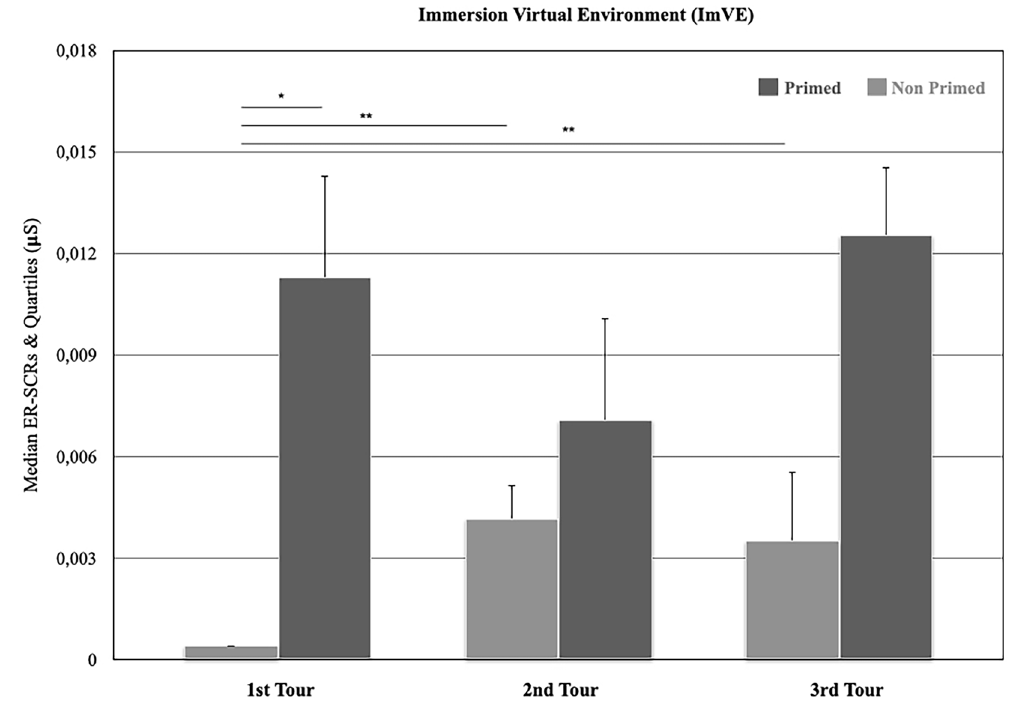
Figure 5. Median SCR comparisons between “primed” and “non primed” participants during the immersion into virtual environment (ImVE) for the 1st, 2nd and 3rd tours (* p < 0.05 , ** p <